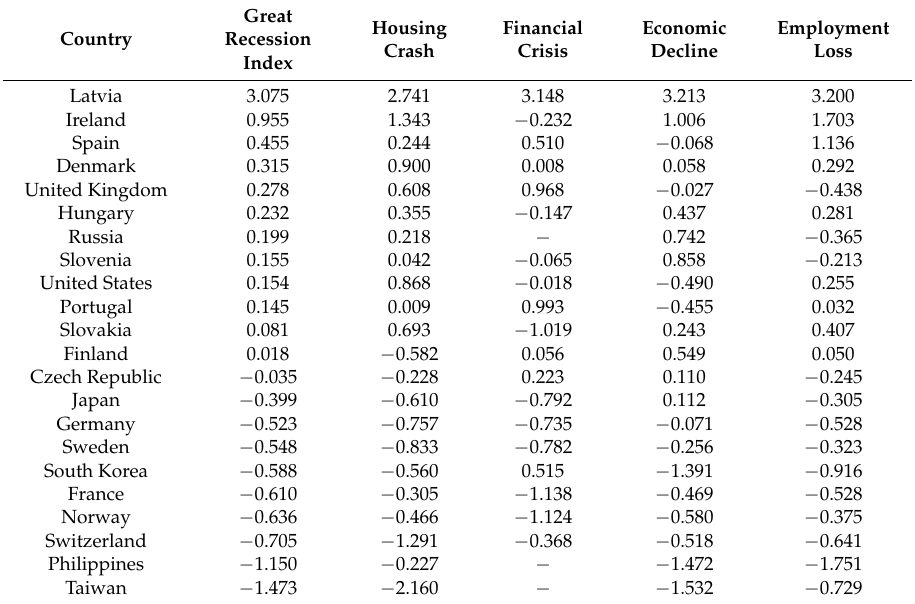
Table 2. The Great Recession Index and its components for 22 countries.